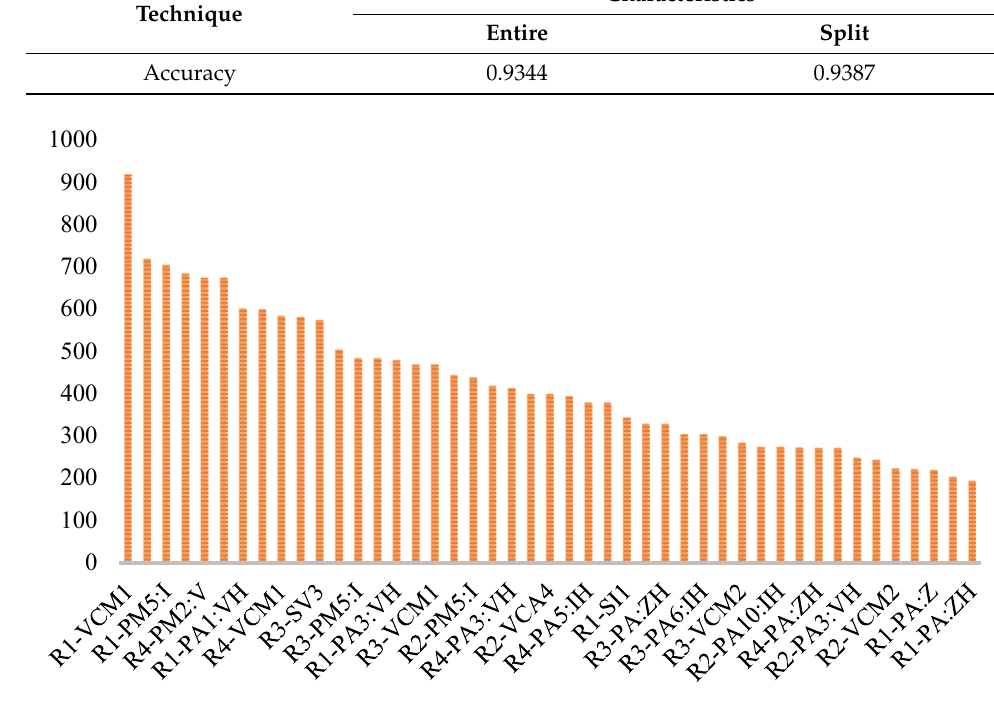
Table 5. Diverse methods to procedure Inf and